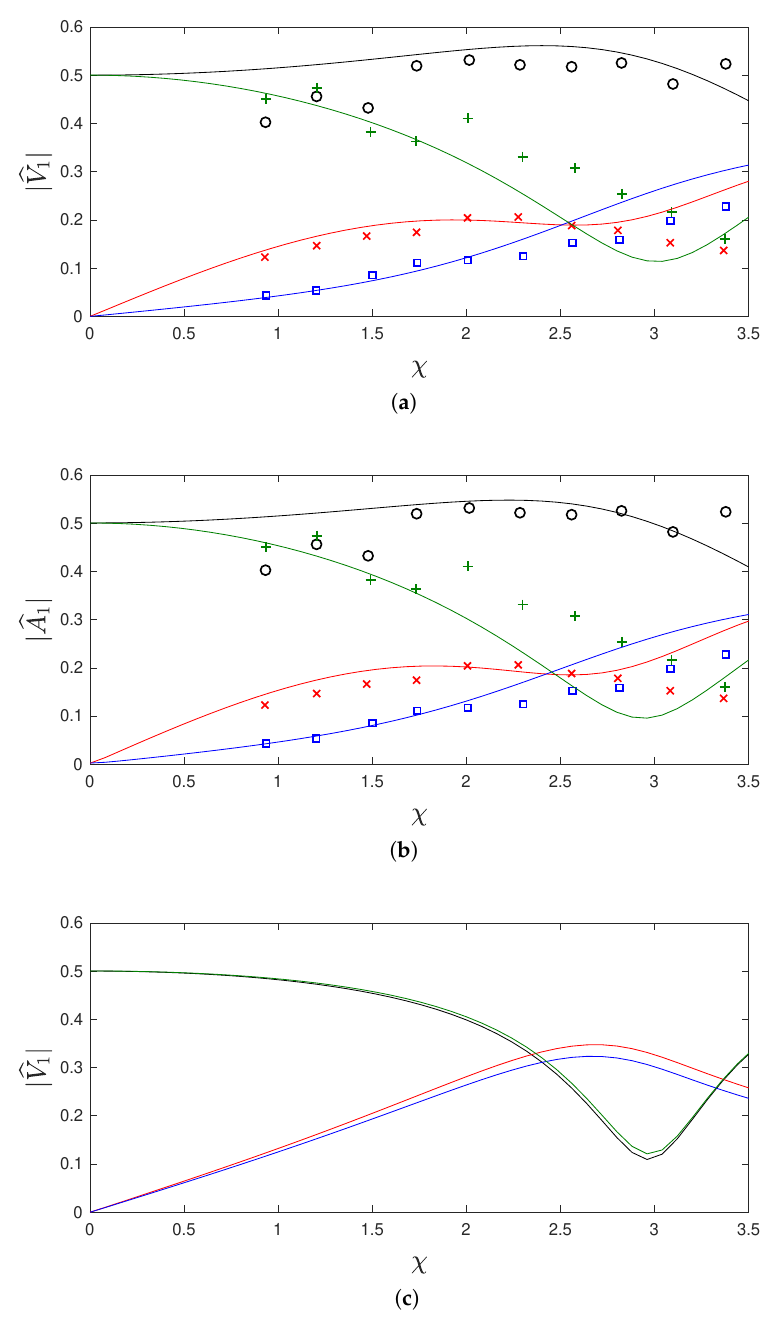
Figure 2. Measured (symbols) and computed (lines) sideband amplitudes of the first harmonic for Keller’s experiment [42] as shown in Figure 1: κ = − 1 (green), κ = + 1 (black), κ = − 3 (red), κ = + 3 (blue). The panels correspond to ( a ) our model (32), ( b ) spatial form (36) of the classical Dysthe’s equation, ( c ) cubic nonlinear Schrödinger (NLS)